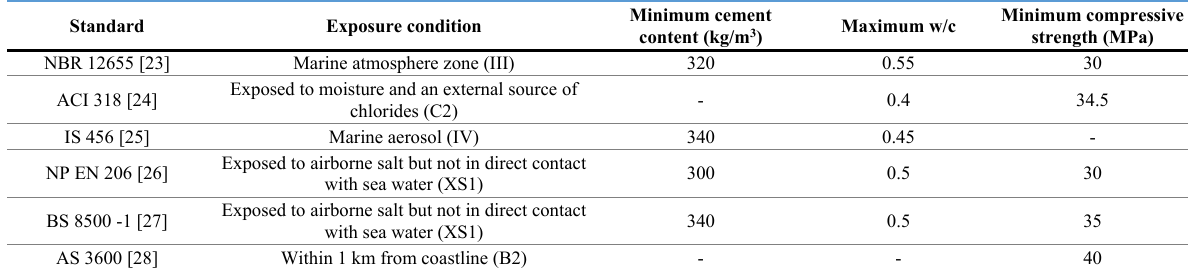
Table 1. Requirements for concrete in marine atmosphere zones - data from national and international standards